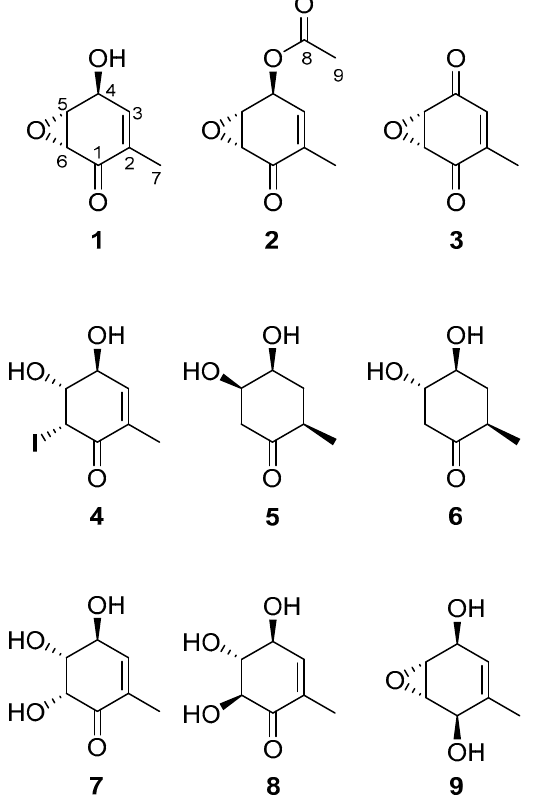
Figure 1. Structure of (+)- epi -epoformin ( 1 ) and derivatives ( 2 – 9 ).